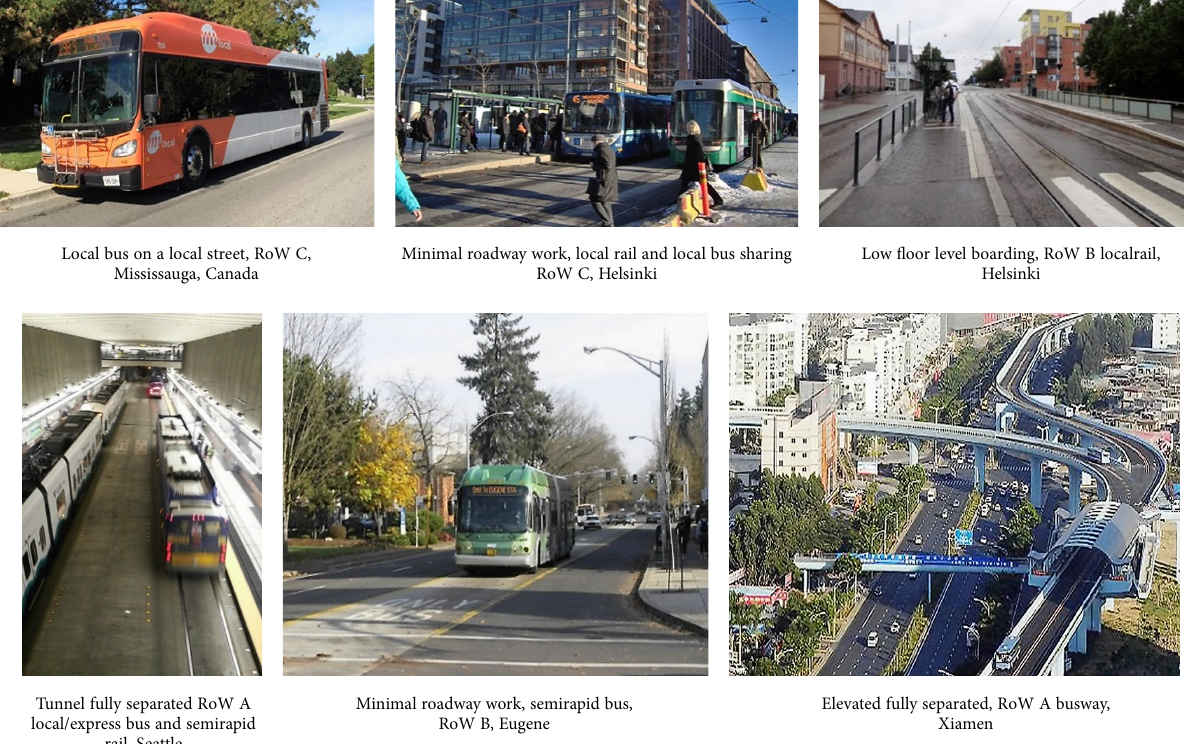
Figure 1. Different PT systems in different RoWs using Bus or Rail